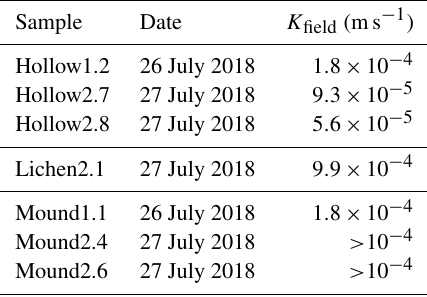
Table 6. Hydraulic conductivity values (ms − 1 ) obtained using a double-ring infiltrometer during the sampling